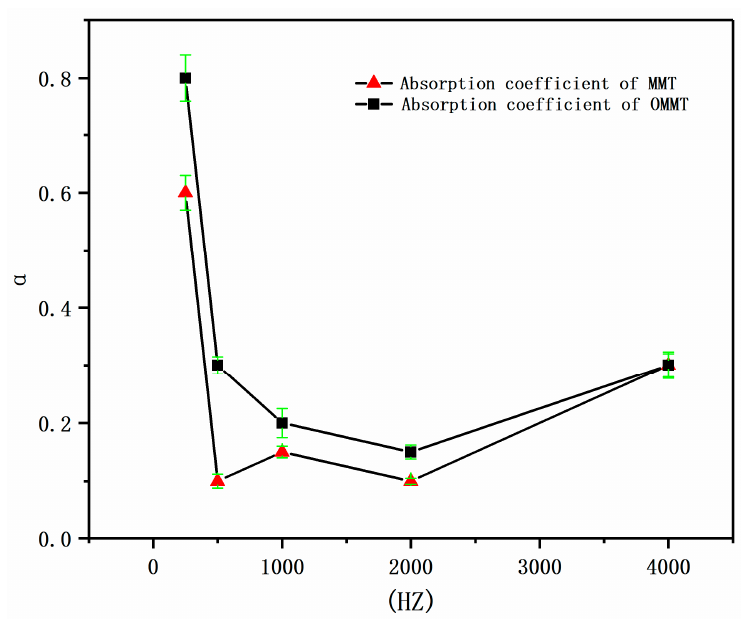
Figure 11. Comparison diagram of sound absorption coefficient of MMT and OMMT.